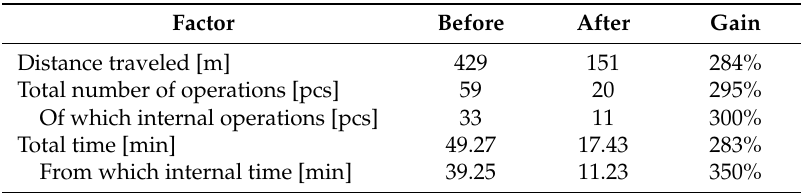
Table 2. Results obtained after applying the